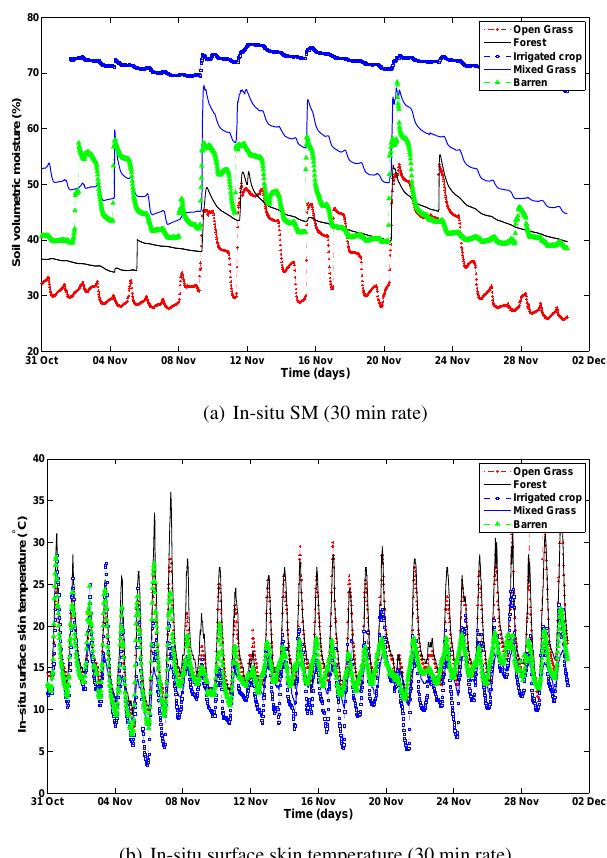
Figure 2: a. Variations of the near-surface ( < 5 cm depth) volu- metric soil moisture, and b. variations of surface skin temperature over different LC types during the field measurements (Nov-Dec.